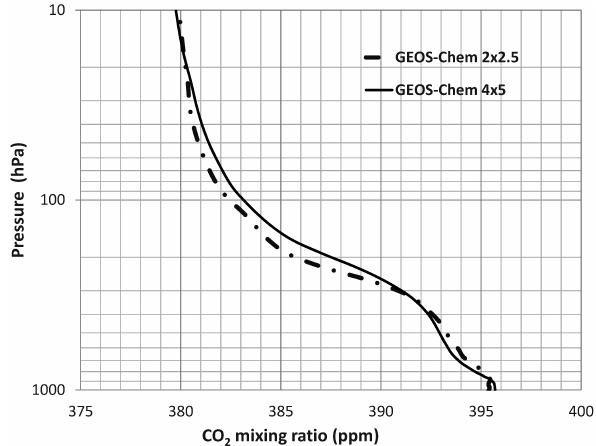
Figure 11. Zonal mean profiles of CO 2 at 75 ◦ N on 1 April 2010 from the GEOS-Chem 4 ◦ × 5 ◦ and 2 ◦ × 2.5 ◦ simulations. The sim- ulations began with the same initial conditions on 1 July 2009. The fossil fuel, biofuel, ocean, and biospheric fluxes used in the simu- lations were scaled based on the a posteriori scaling factors from the GOSAT XCO 2 inversion. The biomass burning fluxes, however, were not scaled.